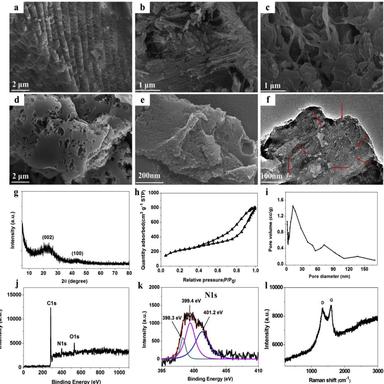
SEM images of raw crab waste (a), carbonized product (b), HCl treated carbonized product (c) and CDC (d, e); TEM image (f), XRD pattern (g), nitrogen adsorption/desorption isotherm (h), pore size distribution (i), XPS survey spectrum (j), high-resolution N1s spectrum (k) and Raman spectrum (l) of CDC.